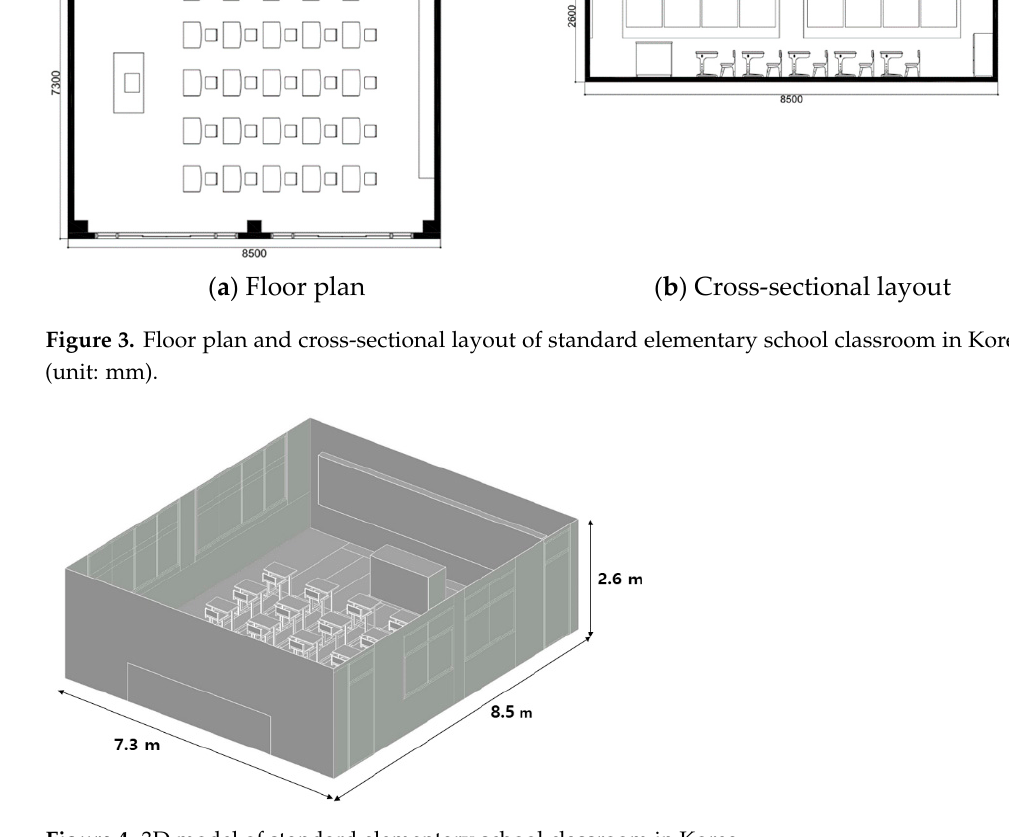
Table 6. Finishing materials for the classroom applied in the simulation.